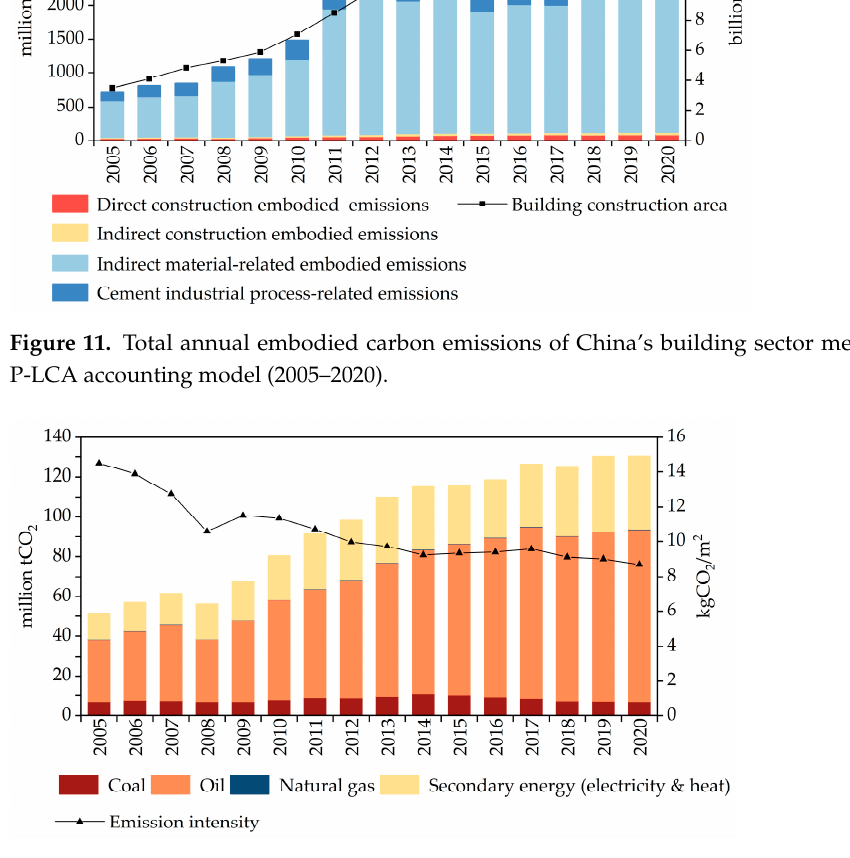
Figure 13. Total annual embodied carbon emissions of China’s building sector measured by the IO- LCA accounting model (2005–2020). From the perspective of ECs composition, the share of each component in the total emissions has not changed noticeably during 2005–2020. The direct ECs from on-site con- struction while building new construction, maintenance, and demolition stages represent about 5% of the total ECs, and the remaining 95% are indirect ECs from building-related industries. Of the 1.57 billion tCO 2 increase in building ECs in 2020 compared to 2005, 96.5% comes from the indirect building ECs. From the perspective of emission intensity, it presents a downward trend, as shown in Figure 14, with the ECs intensity in 2020 decreasing by 24.7% compared to that in 2005.